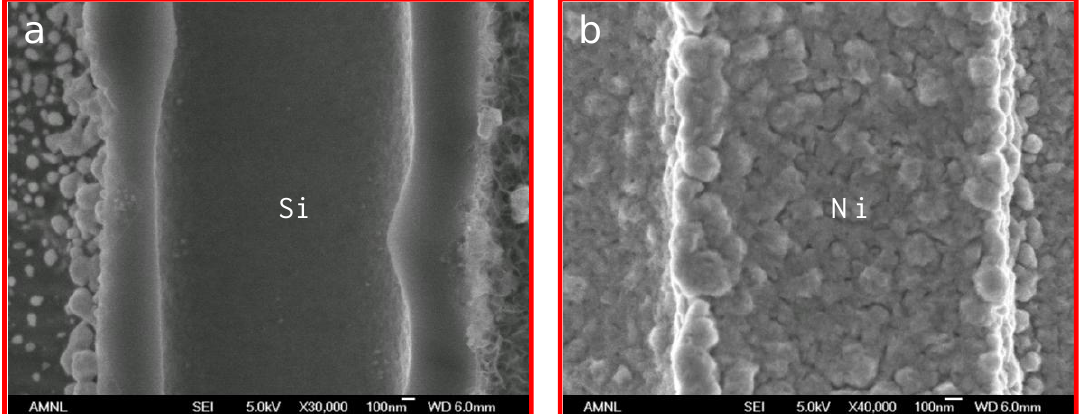
Figure 3. FESEM micrographs of a sample after 1-hour treatment in the Ni bath: ( a) Pore morphology at a level where no significant deposition occurred. (b) Pore morphology at a level where full metallization